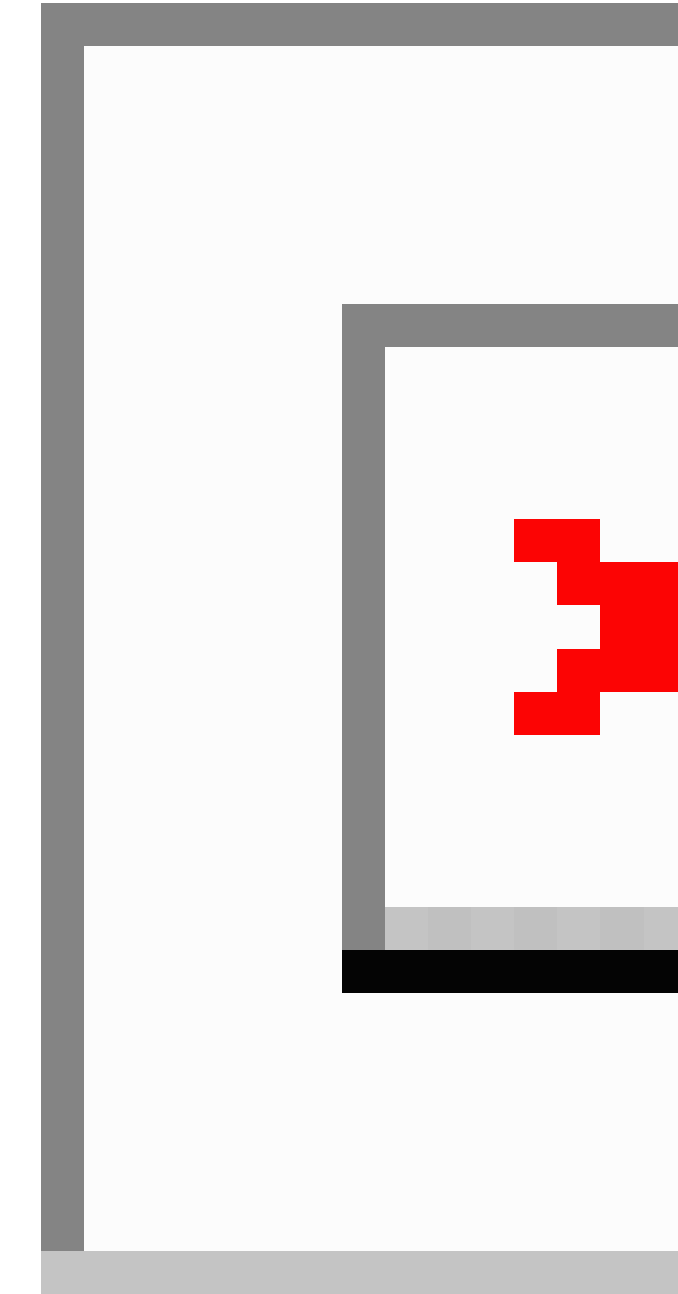
Figure 2. Example of the adapted READY intervention